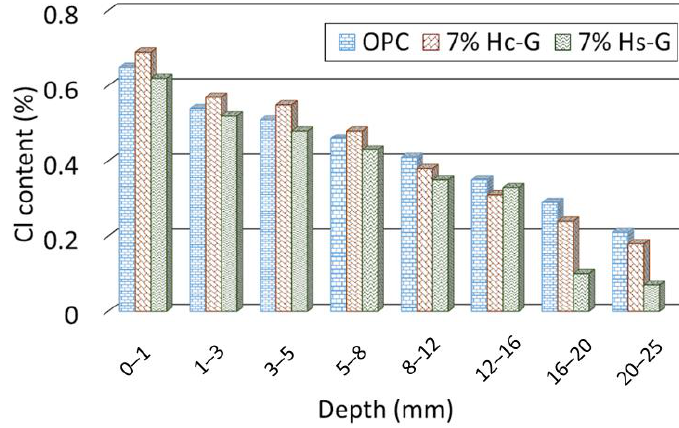
Figure 5. Variation in chloride ion concentration with depth.